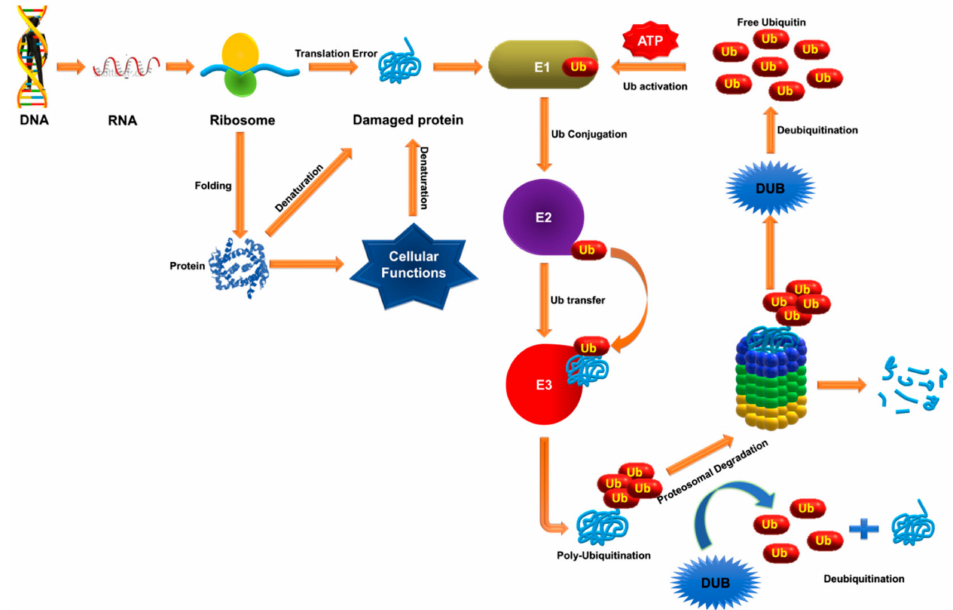
Figure 1. Protein quality control and degradation by the ubiquitin proteasome system (UPS). Nascent polypeptides and misfolded proteins that arise from translational errors are the targets of the UPS, and involves balancing myriad intracellular protein levels. The UPS consists mainly of ubiquitination of the target protein by E3 ligases and degradation of ubiquitinated proteins by the proteasome. Ubiquitination is tagging of a target protein. This cascade of enzyme reactions is catalyzed by the sequential activity of three enzymes: E1 (ubiquitin-activating enzyme), E2 (ubiquitin-conjugating enzyme) and E3 (ubiquitin ligase). This process is counterbalanced by Ub proteases belonging to either metalloprotease or cysteine protease. These DUBs cleave the ubiquitin molecule from the substrate protein, maintaining the pool of mono-Ub which is supplied for the ubiquitination of misfolded proteins. Any disturbance in the equilibrium between ubiquitination and deubiquitination can induce